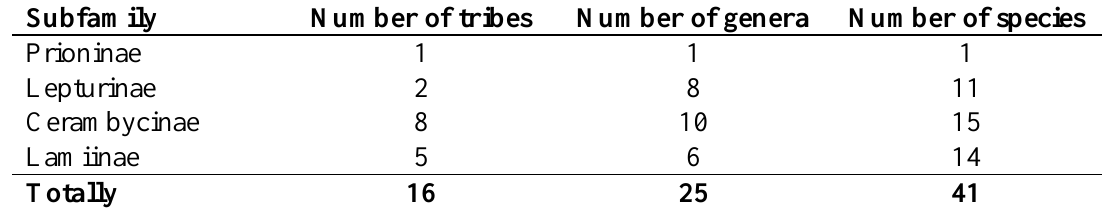
Table 1. Total number of longhorn beetle taxa collected on the Gledi ć Mountains from 2011 to 2013 and the numbers of the taxa within